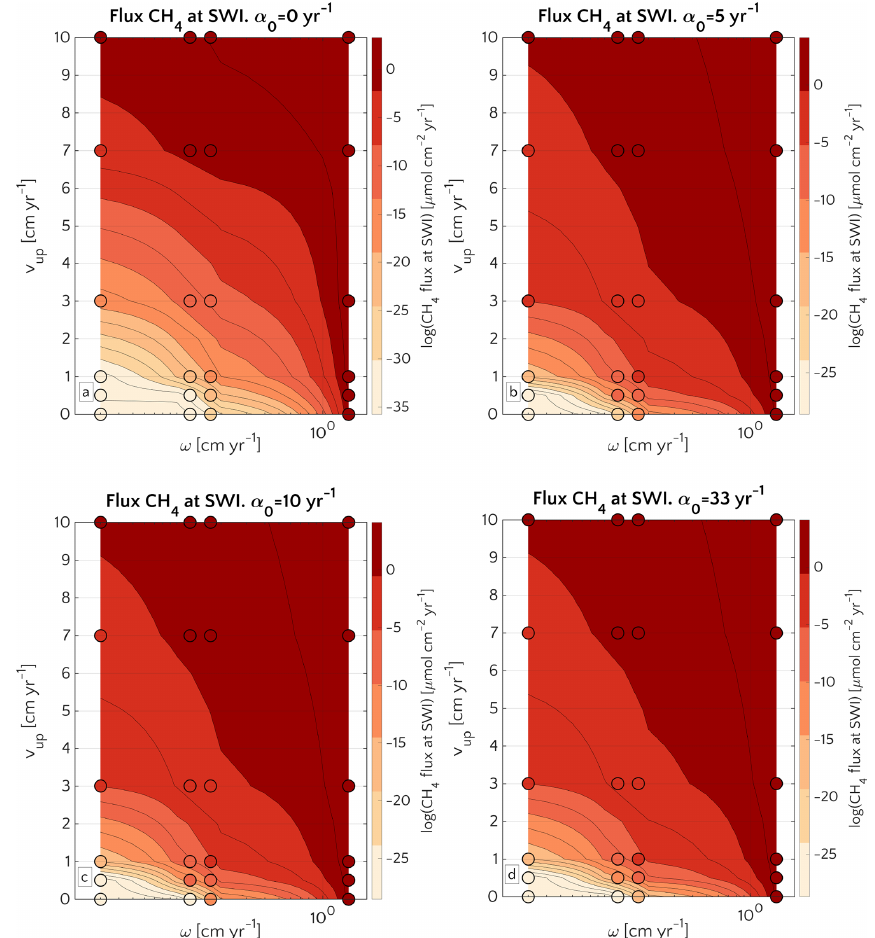
Figure 6. Efflux of methane at the SWI as dependent on v up and ω for α 0 = 0 (a) , α 0 = 5 (b) , α 0 = 10 (c) and α 0 = 33yr − 1 (d) . Circles represent simulations outcomes. Results for α 0 (cid:54)= 0yr − 1 are almost the same. The lower boundary condition for methane is [ CH 4 ] − = 1 . 169mM. A three-dimensional version of the plot is reported in Fig.